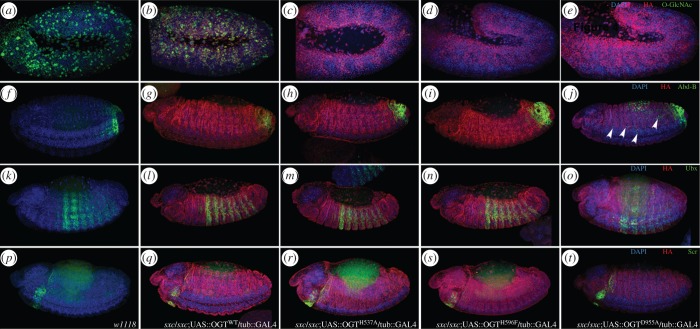
Repression of Hox genes in DmOGT point mutant-rescued F2 embryos. Stage 9–11 (a–e) or stage 13–14 (f–t) F2 embryos were immunostained with O-GlcNAc (RL2; a–e), Abd-B (f–j), Ubx (k–o) or Scr (p–t) antibodies. F2 embryos from w1118 (a,f,k,p) or crosses between F1 siblings with the following genotypes were collected, fixed and immunostained: sxc1/sxc6;UAS::OGTWT/tub::GAL4 (b,g,l,q), sxc1/sxc6;UAS::OGTH537A/tub::GAL4 (c,h,m,r), sxc1/sxc6;UAS::OGTH596F/tub::GAL4 (d,i,n,s) and sxc1/sxc6;UAS::OGTD955A/tub::GAL4 (e,j,o,t). White arrowheads indicate derepression of Abd-B in sxc/sxc;UAS::OGTD955A/tub::GAL4 embryos (j).